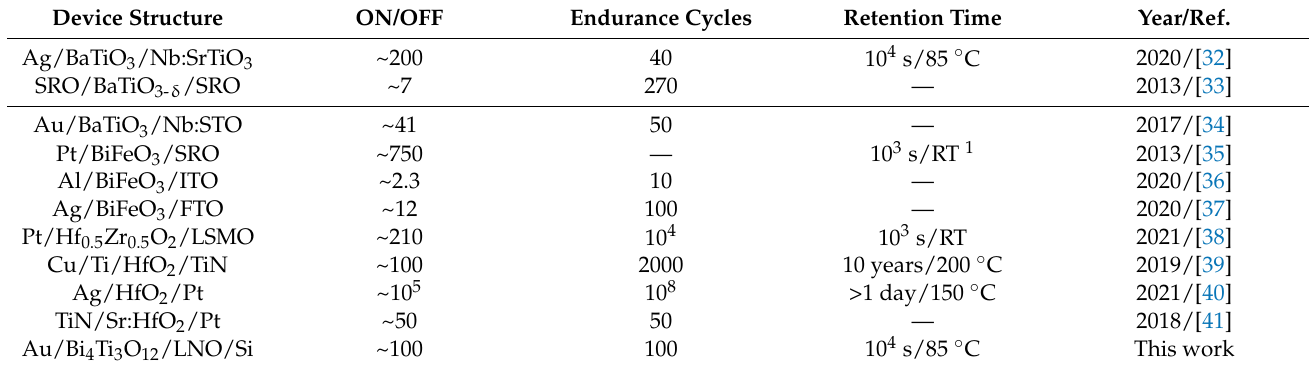
Table 1. Comparison of resistive switching performance of RRAM devices.